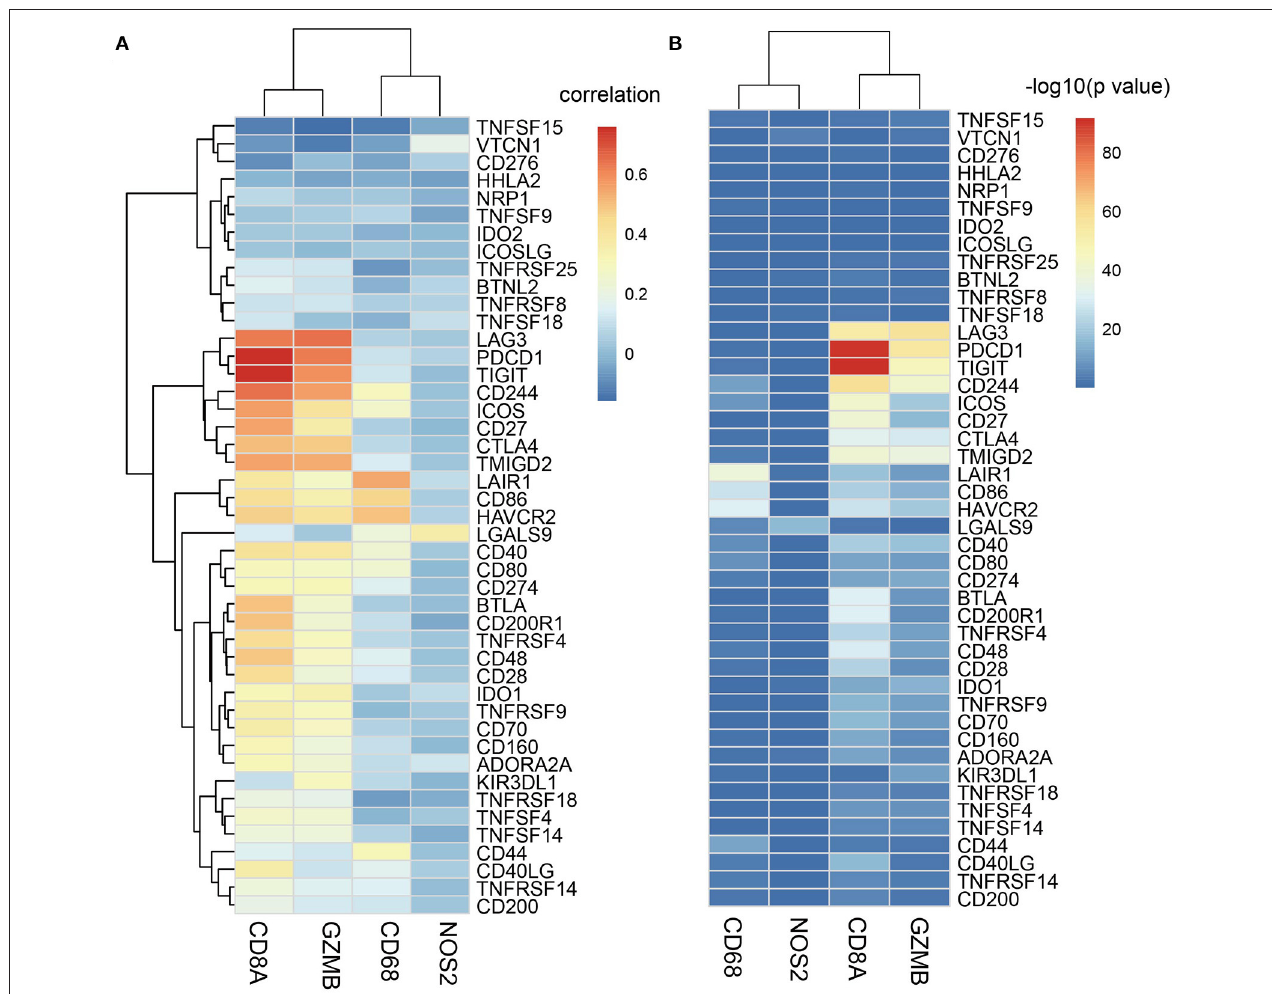
FIGURE 6 | (A) Heatmap of the correlation coefficients between ICGs and adaptive immune-resistance pathway genes. The abscissa represents the genes of the adaptive immune resistance pathway, and the ordinate represents the ICGs; (B) − log10 ( P -value) is tested for the correlation coefficients between ICGs and adaptive immune-resistance pathway genes. The redder the color, the greater the